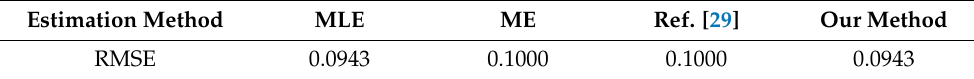
Table 5. The statistics of estimation accuracy in simulated log–normal distribution ( k = 0.5). Estimation Method